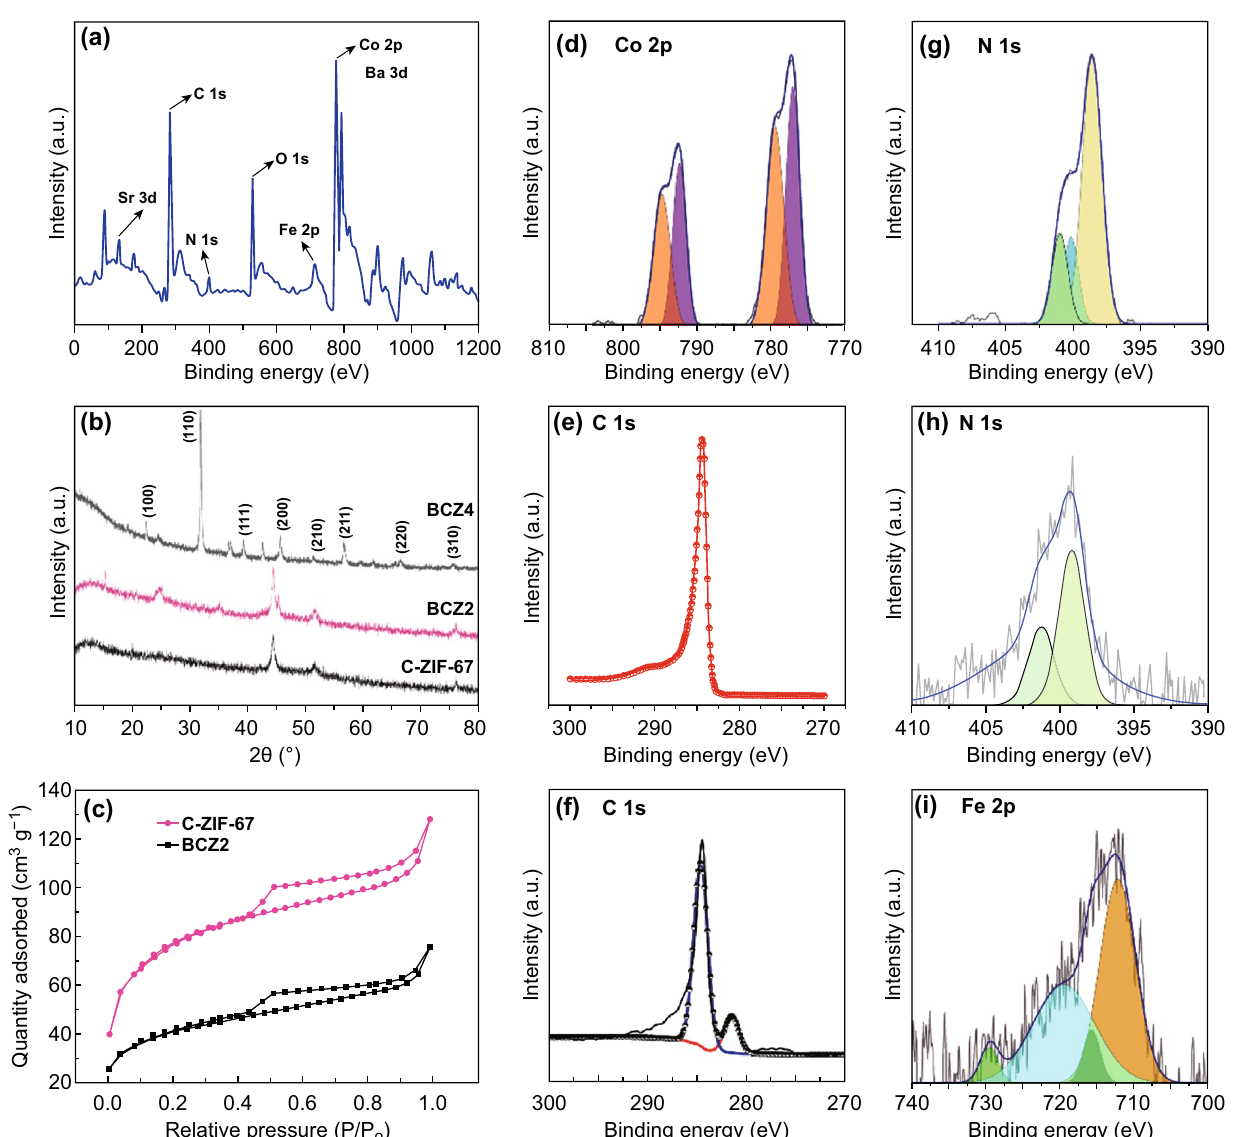
Fig. 2 a XPS survey spectrum of BCZ2 composite. b XRD patterns of carbonized ZIF‑67, BCZ2 and BCZ4 samples. c N 2 adsorption/desorp‑ tion isotherms of carbonized ZIF‑67 and BCZ2 composite. d High‑resolution deconvoluted XPS spectrum of Co 2 p of BCZ2, High‑resolution deconvoluted XPS spectrum of C 1 s of e C‑ZIF‑67 and f BCZ2 composite. High‑resolution deconvoluted XPS spectrum of N 1 s of g carbonized ZIF‑67 h BCZ2 composite. i High‑resolution deconvoluted XPS spectrum of Fe 2 p of